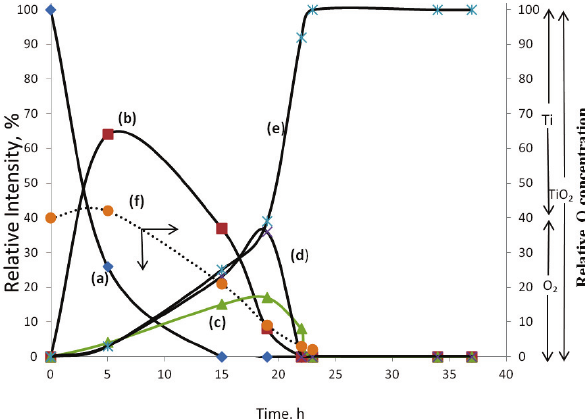
Figure 5. Relative Intensity of the principal peaks and an- alytical oxygen concentration. (a) TiO CaTi O , (c) TiO, (d) Ti 2 4